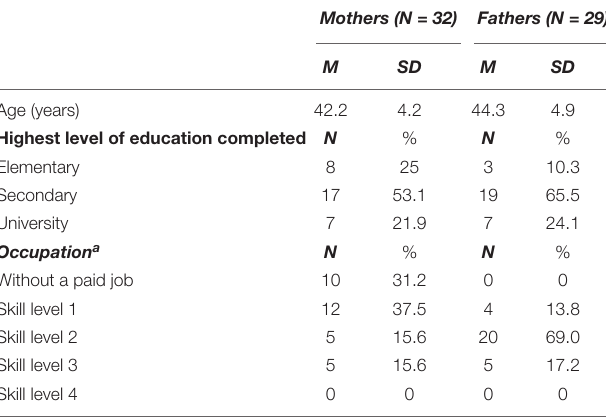
TABLE 2 | Characteristics of parent